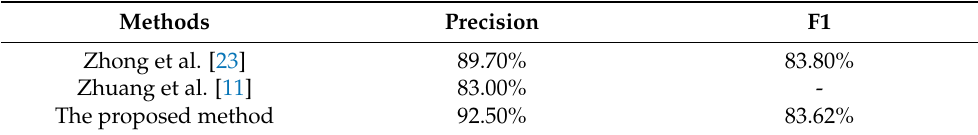
Table 4. The comparison results of three